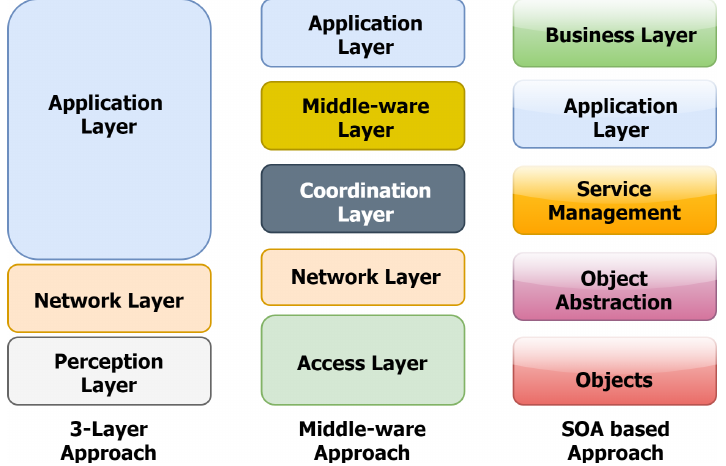
Figure 6. The IoT architecture: layered model